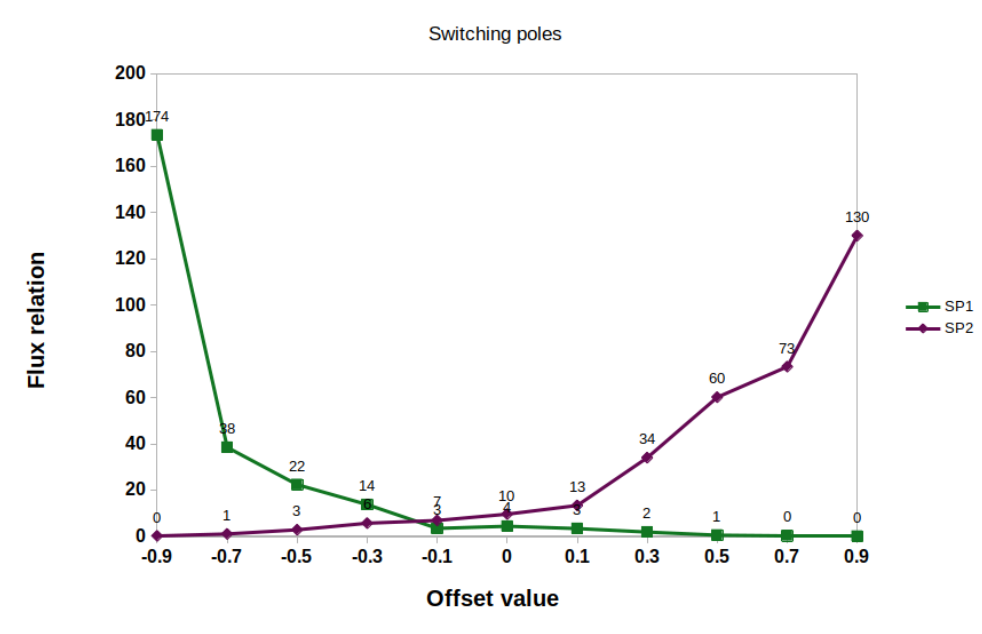
Figure 18. Dependence of the ratio of the hot spots luminosities on the magnitude of the dipole displacement for the asynchronous polar CD Ind. The curve SP1 corresponds to the flow switching from the south magnetic pole to the north, the curve SP2–from the north to the